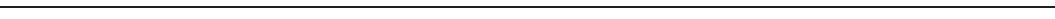
Fig. 2. Hyaenodontid mammal Cartierodon egerkingensis gen. and sp. nov. from Switzerland, Egerkingen γ (MP13?, Lutetian, Eocene). A . NMB.Ek.42, DP4 in occlusal (A 1 ) and labial (A 2 ) views. B . NMB.En.213, dp3 in occlusal (B 1 ), labial (B 2 ), and lingual (B 3 ) views. C . NMB.En.155, dp4 in